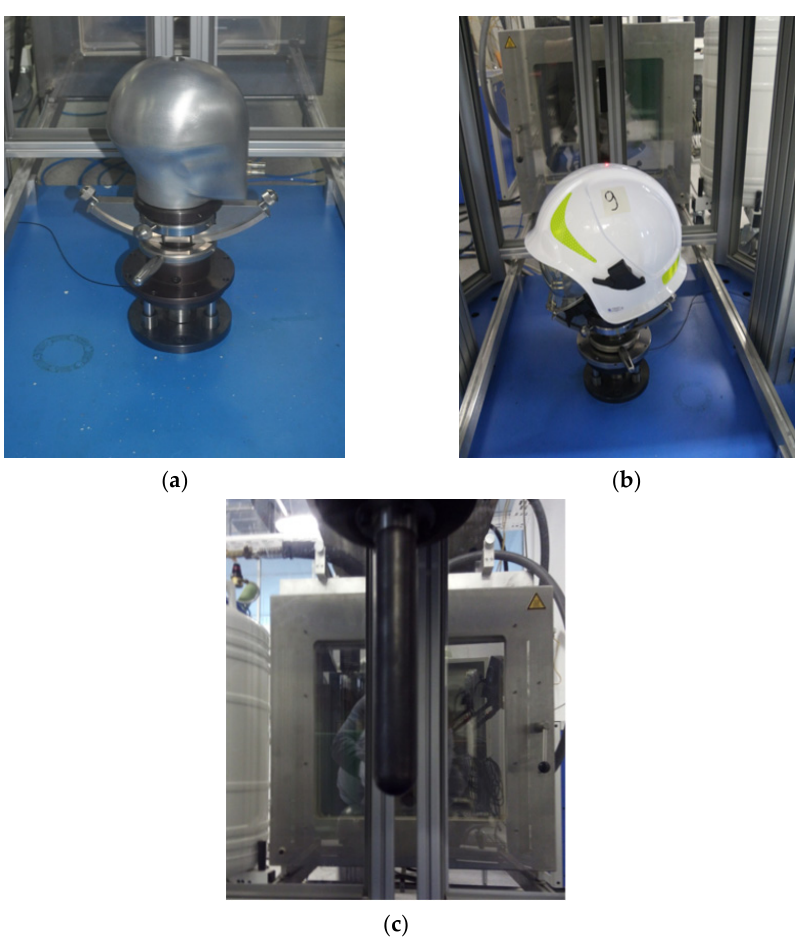
Figure 4. Instrumentation of an impact hammer DFP 1000 intended to test firefighting helmets: ( a ) a static head model, ( b ) the way of placing a helmet on a head model, a laser pointer indicates the point of treating a helmet with the impactor, ( c ) spherically ended impactor that hits a helmet.